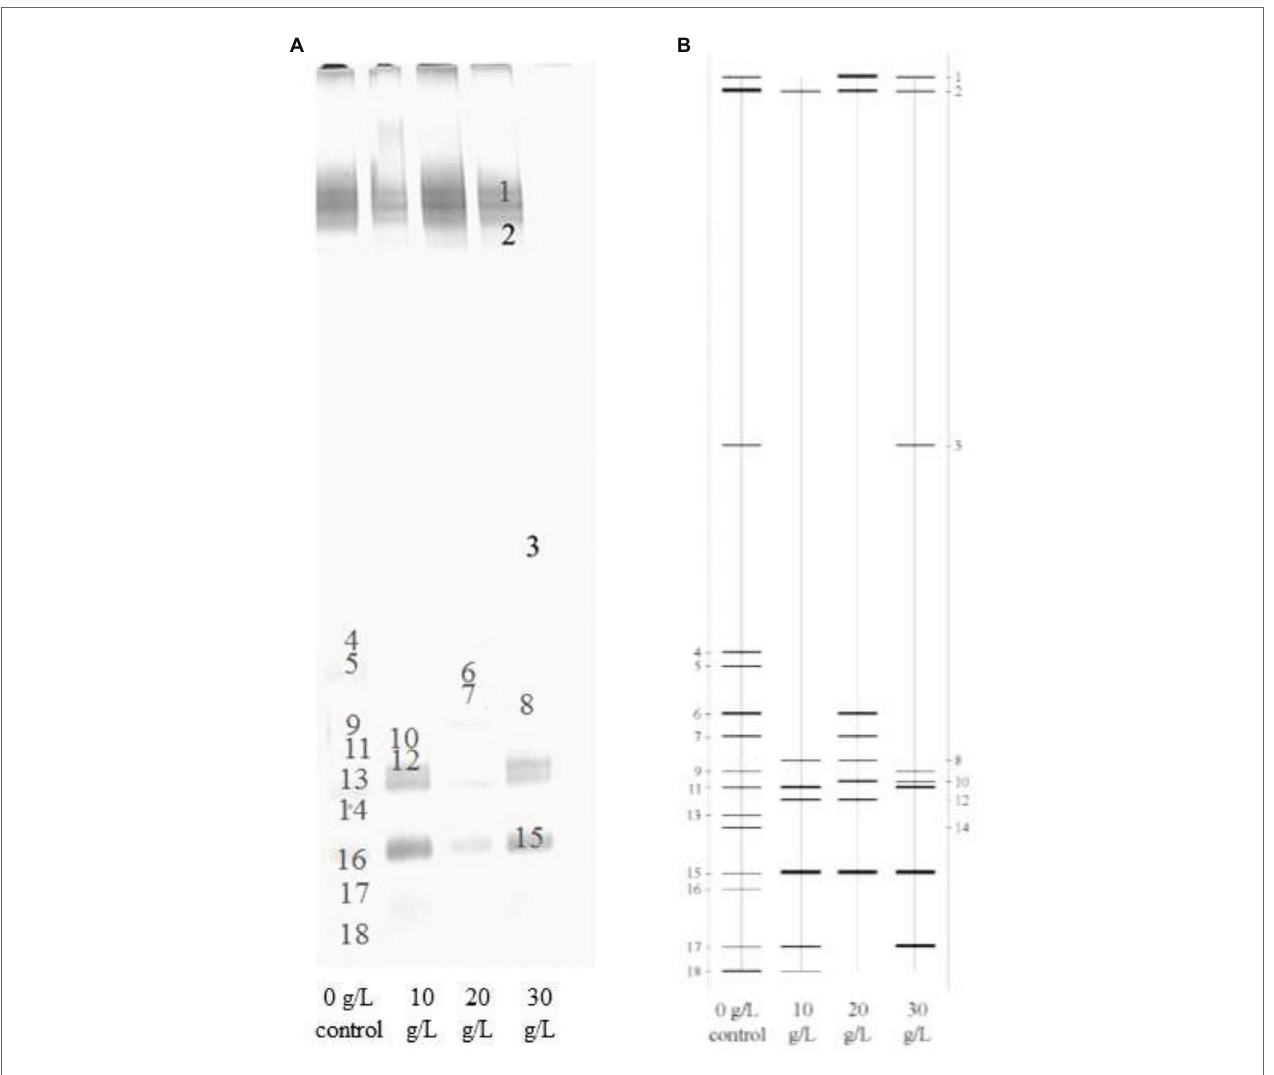
FIGURE 2 | DGGE fingerprint of microbial communities at different NaCl concentrations of 0 (control), 10, 20, and 30 g/L: (A) DGGE profiles and (B) DGGE